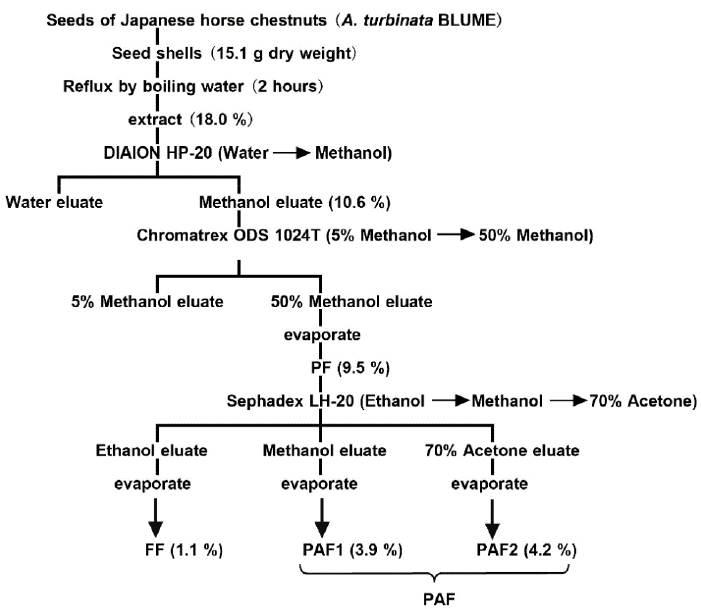
Figure 1. Extraction and purification procedure for a polyphenolic compounds fraction (PF), flavonol O -glycosides fraction (FF), and proanthocyanidin (PAF) from the seed shells of Japanese horse